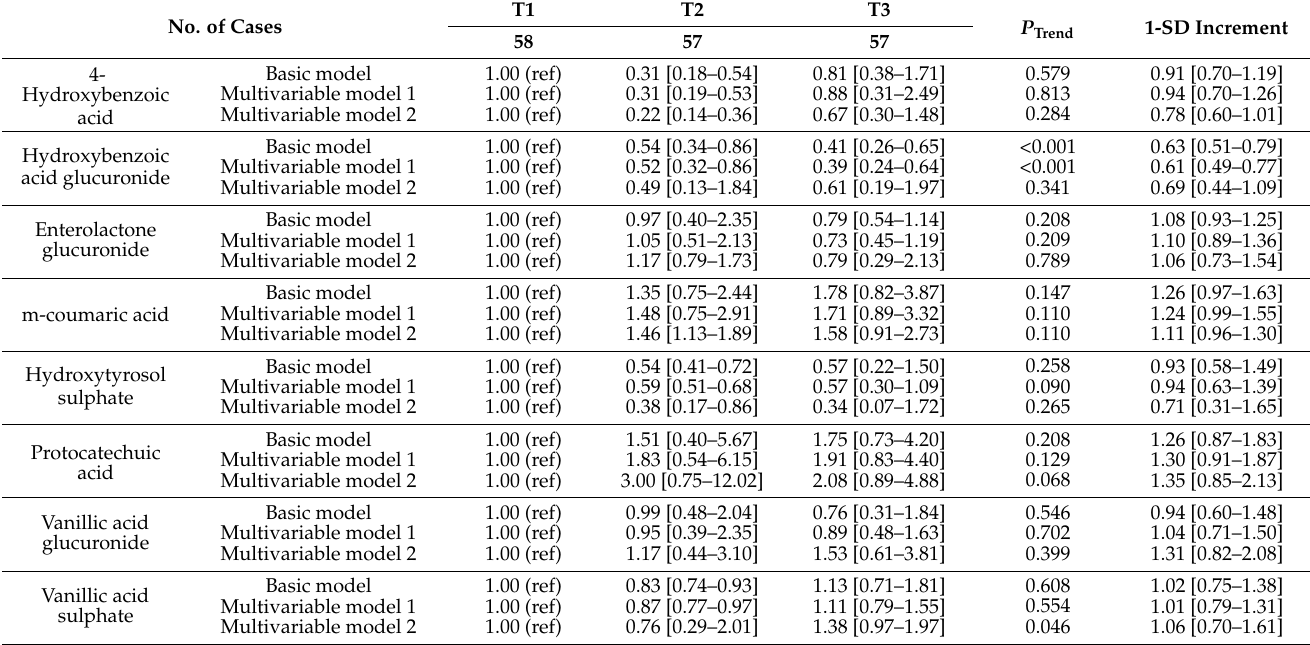
Table 2. Likelihood (OR [95% CI]) of incident type 2 diabetes by tertiles of one-year changes in urinary concentrations of MPMs in the PREDIMED Study.